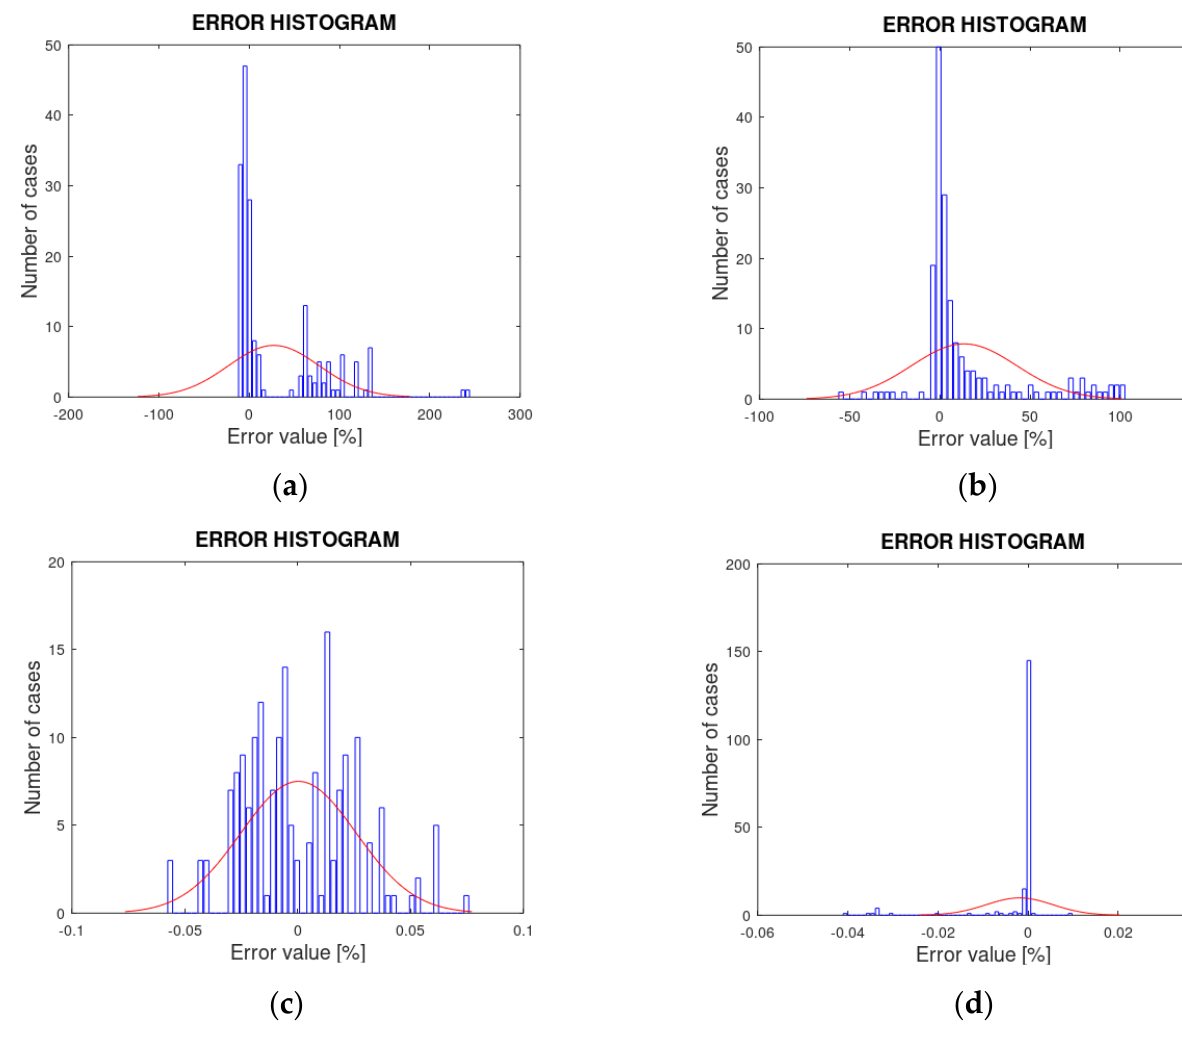
Figure 19. Error histograms: ( a ) comparison C1; ( b ) comparison C4; ( c ) comparison C9; ( d ) comparison C12. The distribution of the errors, following error theory, conforms to a normal distribution centered on the zero value, as shown in Figure 19. The detailed formulations of the metrics used appear in the